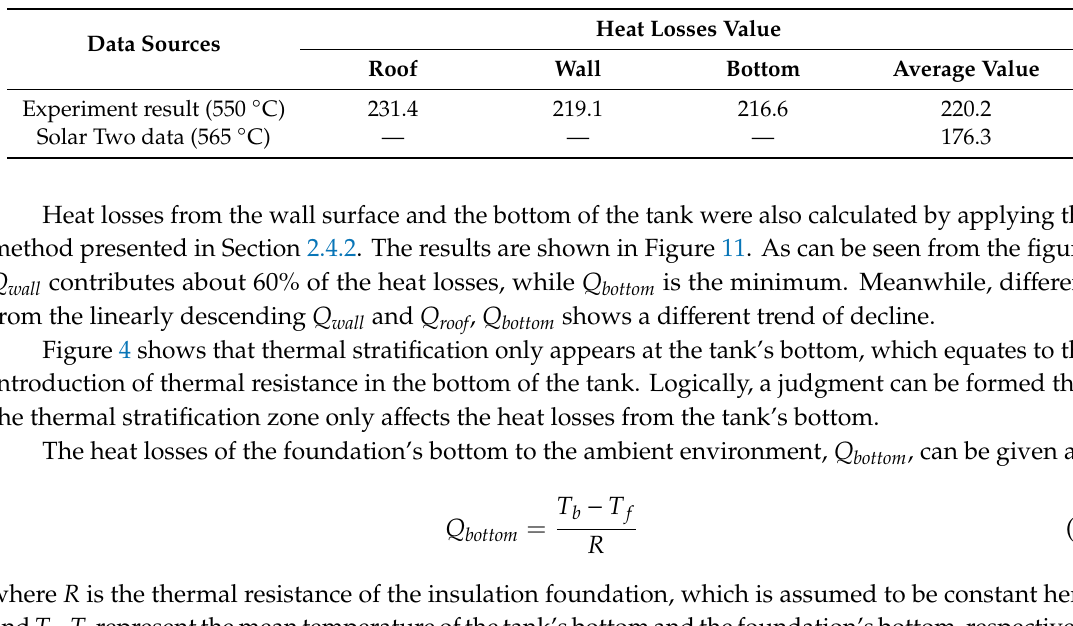
Table 4. Comparison of heat loss data from the experimental tank and Solar Two (W / m 2 ). Data Sources